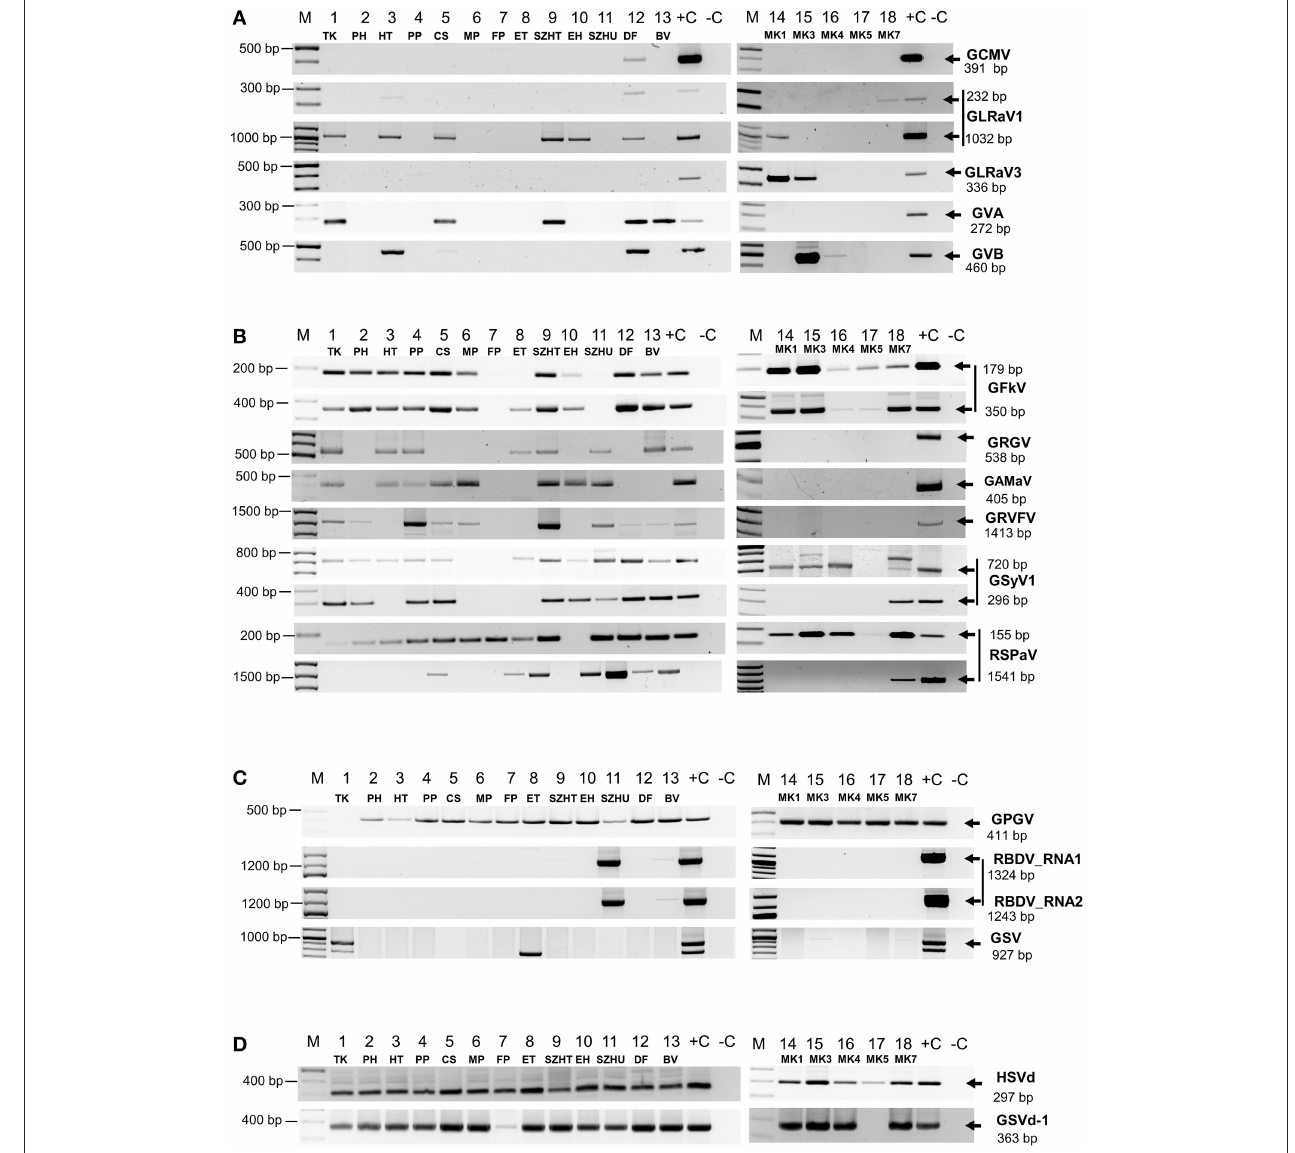
FIGURE 2 | RT-PCR validation of sRNA NGS for (A) Nepo -, Leafroll -, and Vitiviruses, (B) Tymoviruses, (C) viruses which presence is not routinely tested and (D) viroids. cDNA was synthetized from pooled RNA extracts representing each vineyard using random primer and used as templates for PCR reactions with published diagnostic primers or new ones designed according to the consensus sequence generated by mapping our small RNA reads to the reference genomes. To detect GRVFV we used cDNA generated with a GRVFV-specific primer. PCR products were analyzed by agarose gel electrophoresis. (M), GenRuler 100 bp + ; ( + C), cDNA containing the tested virus was used as positive, or (–C), water as negative